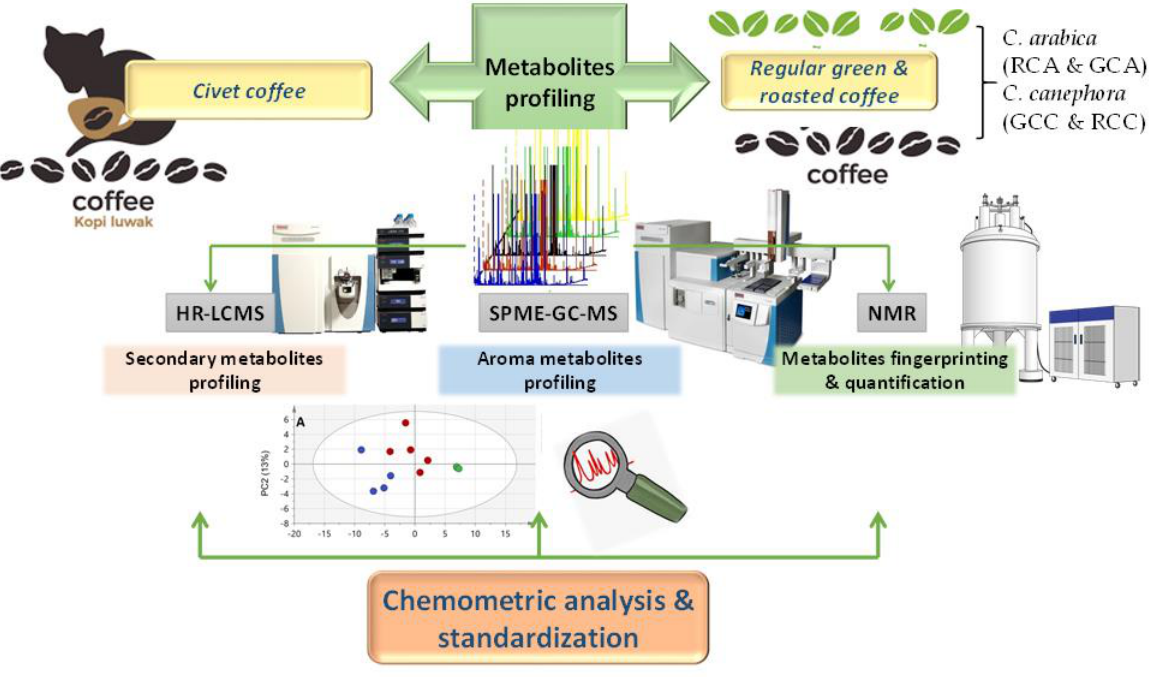
Figure 1. Graphical sketch summarizing the current paper’s objectives and the techniques employed for comparisons between Luwak and regular coffee types.